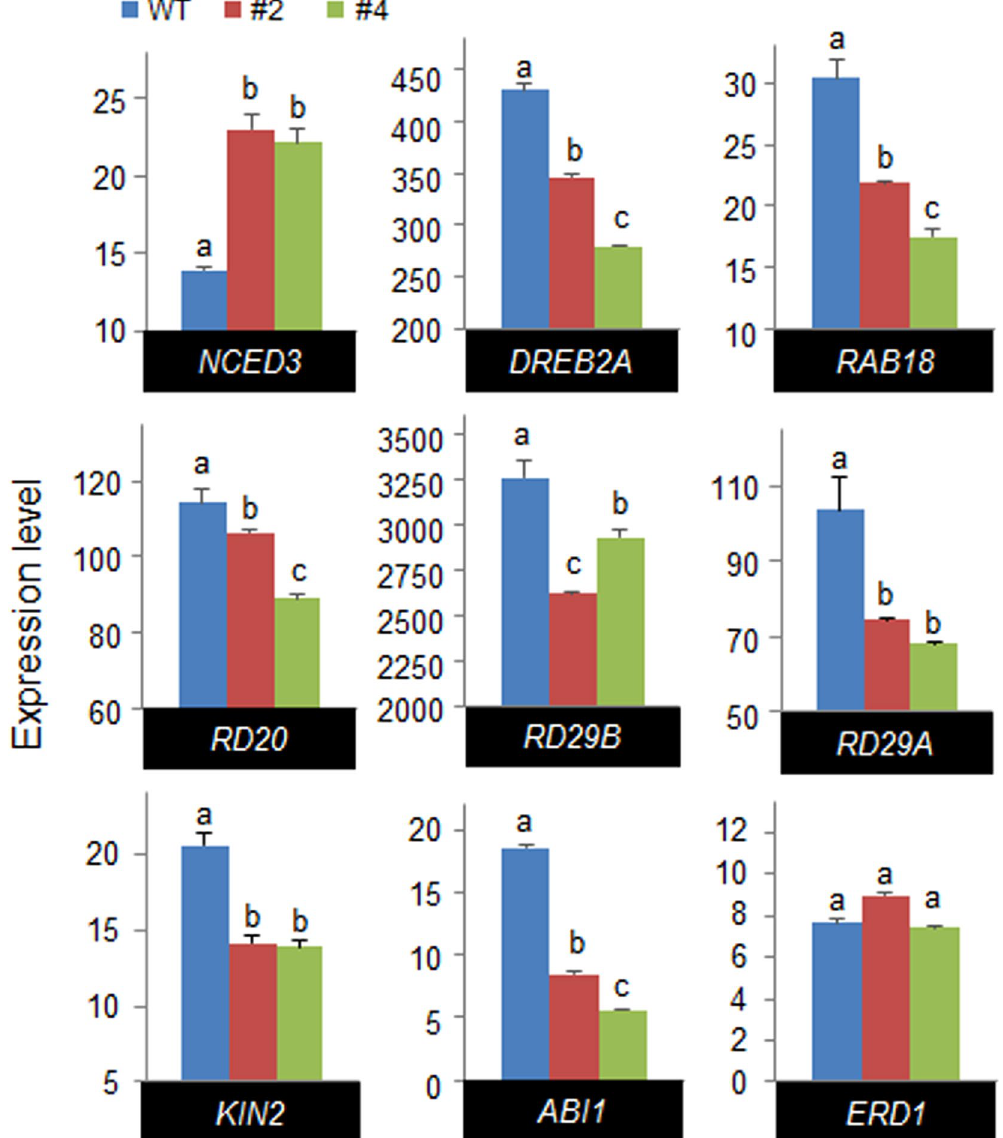
Figure 6. Expression of drought stress-responsive genes in CaREL1 -OX plants. CaREL1 -OX plants were exposed to drought stress and the expression levels of ABA-dependent stress-related genes were measured 3 h after detachment using quantitative reverse transcription-polymerase chain reaction (qRT-PCR) analysis. The relative expression levels ( ∆∆ CT) of each gene were normalized to the geometric mean of Actin8 as an internal control gene. Data represent the mean ± standard error of three independent experiments. Different letters indicate significant differences between wild-type and transgenic lines ( P < 0.05; ANOVA followed by Fisher’s LSD